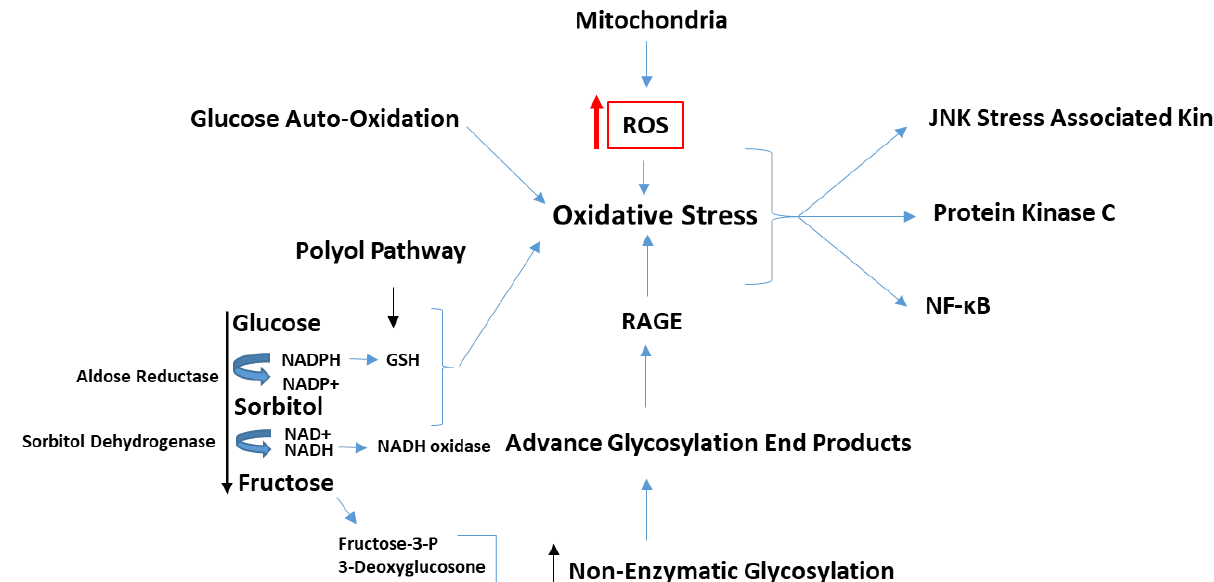
Figure 3. Hyperglycemia induced ‘oxidative-stress’ and its implications. A significant amount of glucose can be shunted via the polyol path, which can lead to oxidative stress through several known signaling pathways affecting vital cellular processes (such as overutilization of NADPH by AR that causes an inability to regenerate GSH and thus decreases the overall antioxidant capacity of the cell). Similarly, SDH results in a buildup of NADH, a substrate for NADH oxidase which produces ROS. Fructose from the polyol path is metabolized to Fructose-3-P, and 3-Deoxyglucasone; both are potent non enzymatic glycation agents. Additionally, glucose auto-oxidation generates H 2 O 2 , O 2 -, and OH − , and thus contributes to oxidative stress in cells. Furthermore, binding of AGEs to RAGE is known to generate intracellular stress.